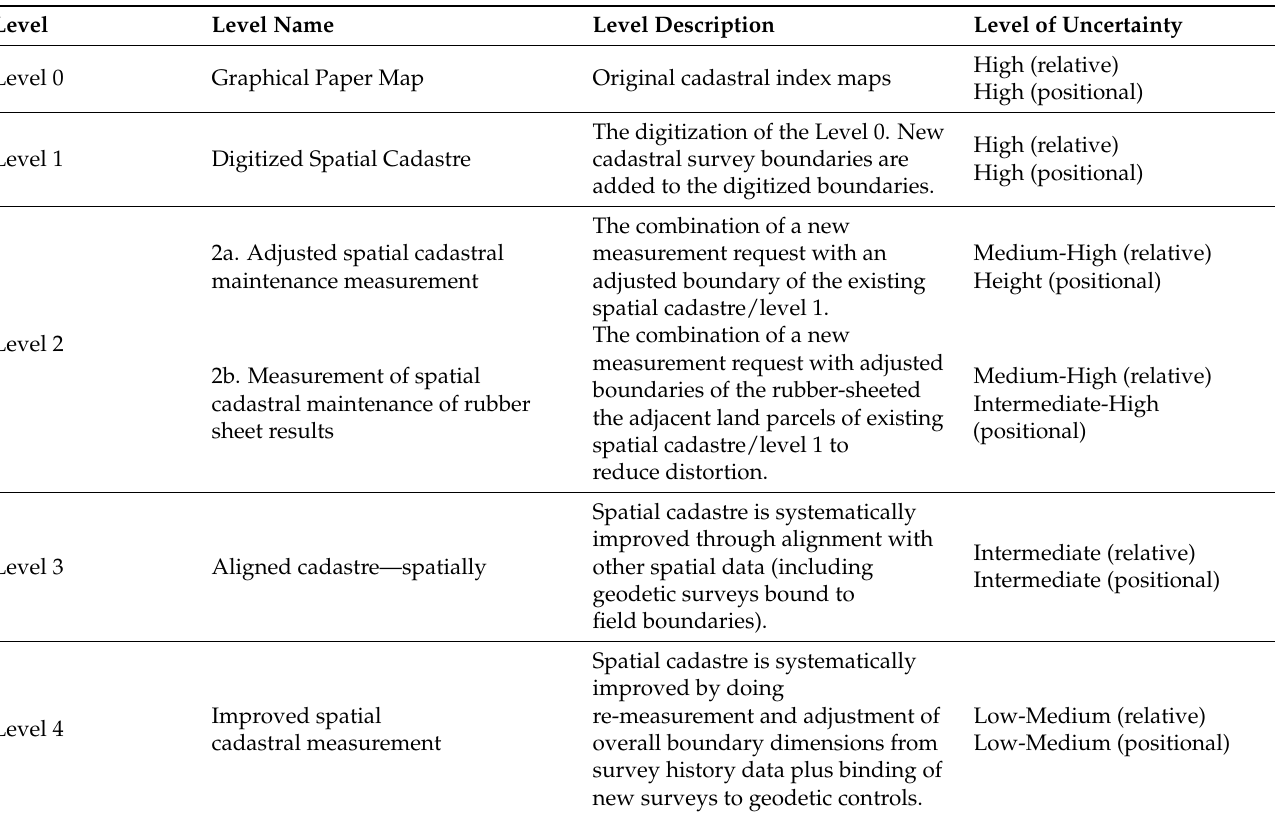
Table 1. Level of improvement of spatial cadastre data quality with indicative uncertainty defined by Grant et al.